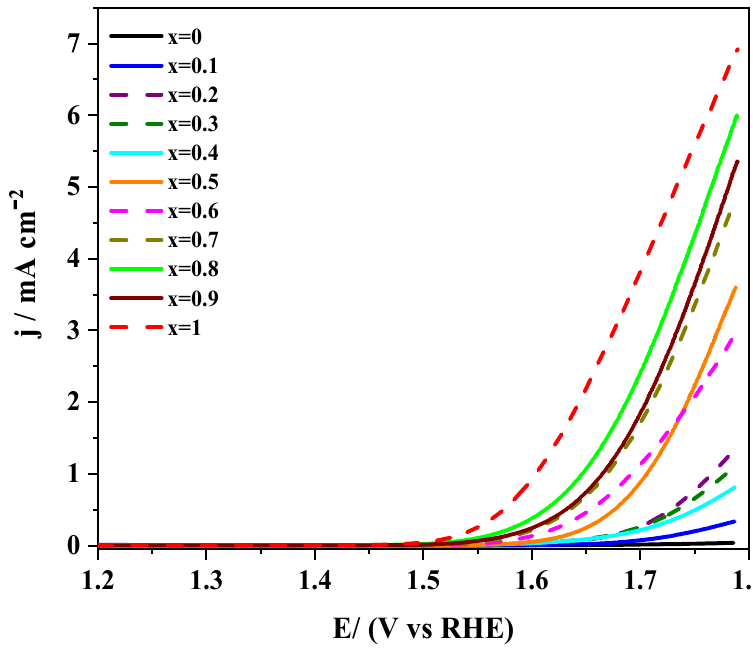
Figure 4. Linear sweep voltammograms recorded for LaMn 1 − x Co x O 3 perovskites in RRDE in 0.1 M KOH saturated with N 2 . Scan rate 5 mV /